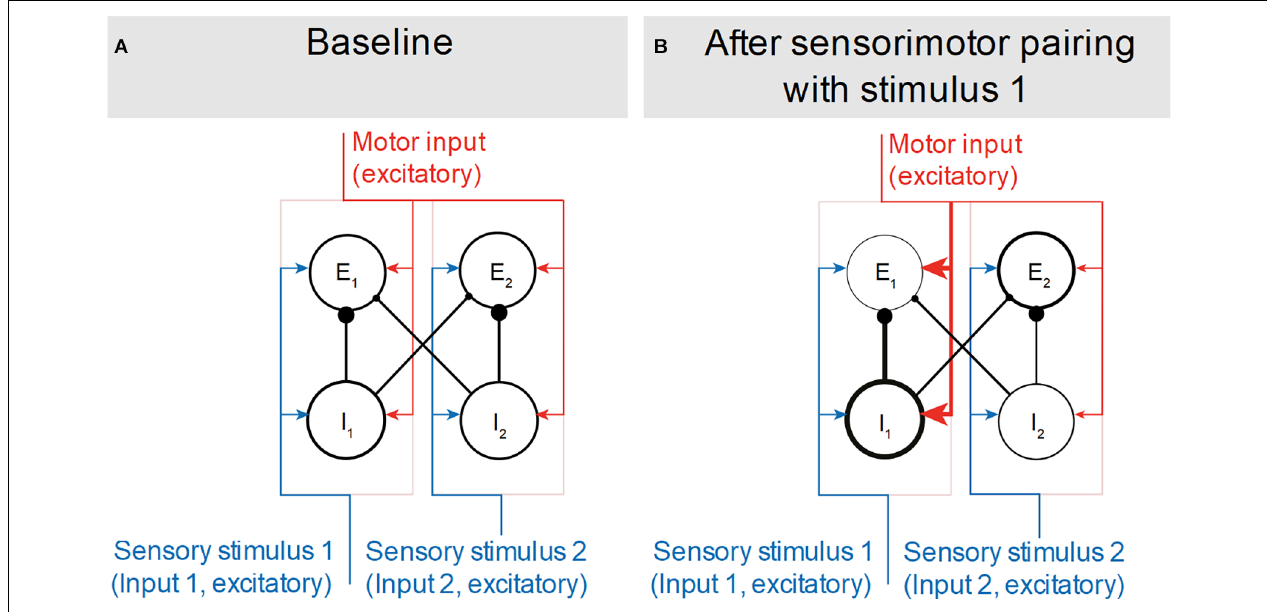
FIGURE 1 | Model of corollary discharge microcircuitry before and after action-stimulus association. (A) In the networks’ baseline state, motor input (red arrows) results in inhibition of sensory responses in all excitatory populations (E 1,2 ). Such generalized inhibition, independent from sensory input (blue arrows) is mediated by all inhibitory populations (I 1,2 ). (B) After repeated paired presentations of motor and sensory input (i.e., stimulus 1), the motor input results in stimulus-specific inhibition for the paired sensory input. Specific inhibition is likely mediated by long-term potentiation of motor-to-sensory synapses (thick red arrows), which results in increased activation of I 1 interneurons that are tuned to the action-paired stimulus. Circles indicate neural populations and lines indicate their connectivity. Arrows and filled circles indicate excitatory and inhibitory synapses, respectively. Thickness is used to indicate the strength of synaptic connectivity (arrows and filled circles) and stimulus response (circles and lines). Excitatory and inhibitory populations that respond preferentially to the same stimulus are grouped and surrounded by light pink rectangles.